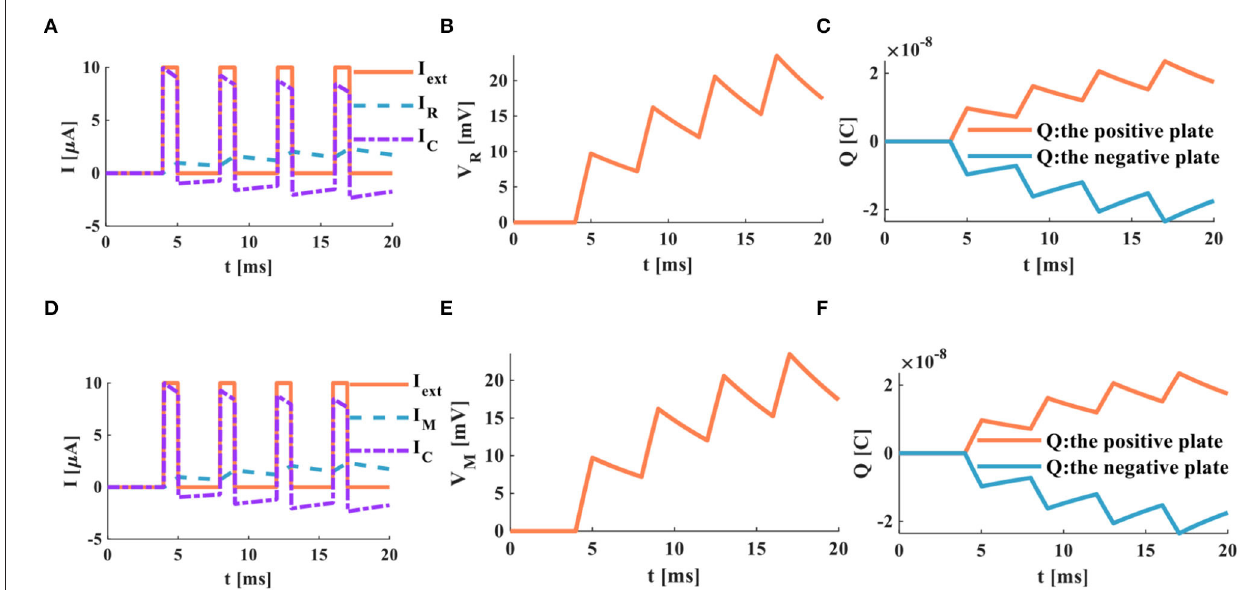
FIGURE 11 | A series of current pulses act on the RC and MC neuron circuits (the number of external stimuli is 4), (A) the current flows through the resistor R and the capacitor C, (B) the membrane potential of the RC circuit, (C) the charges on the positive and negative plates in the RC circuit, (D) the current flows through the memristor M and the capacitor C, (E) the membrane potential of the MC circuit, (F) the charges on the positive and negative plates in the MC circuit.